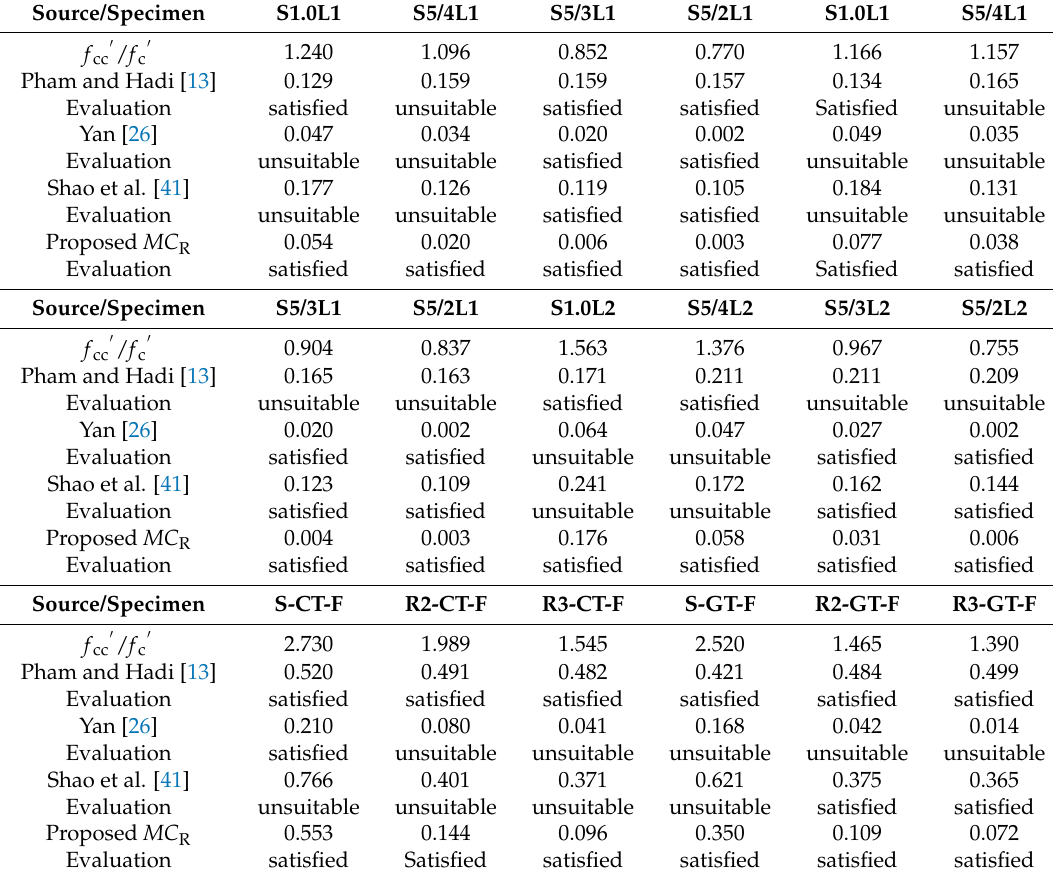
Table 3. Comparison of published (Table 2) and proposed models for specimens in Table 1.